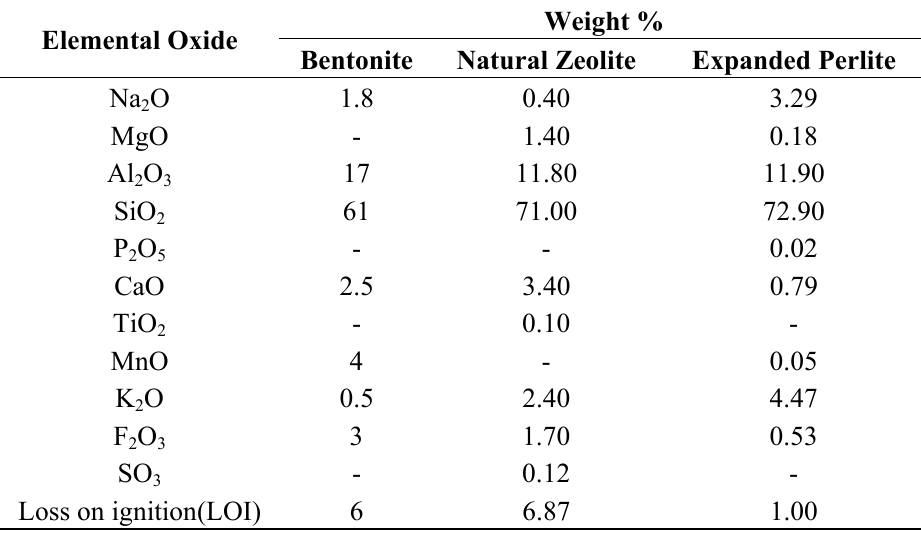
Table 1. Results of chemical analysis of the bentonite, natural zeolite and expanded perlite used in